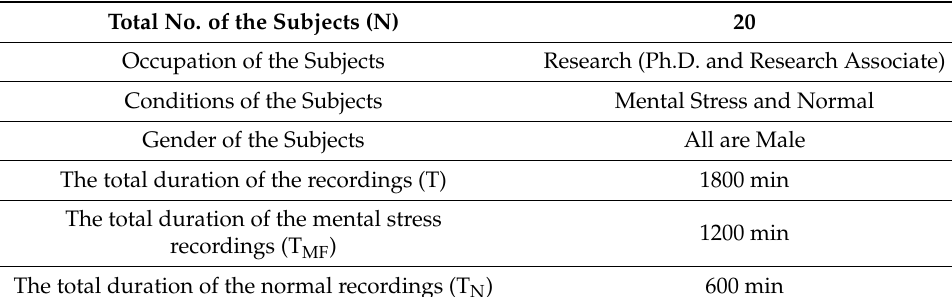
Table 1. Description of the experimental dataset. Total No. of the Subjects (N) 20 Occupation of the Subjects Research (Ph.D. and Research Associate) Conditions of the Subjects Mental Stress and Normal Gender of the Subjects All are Male The total duration of the recordings (T) 1800 min The total duration of the mental stress 1200 min recordings (T MF ) The total duration of the normal recordings (T N ) 600